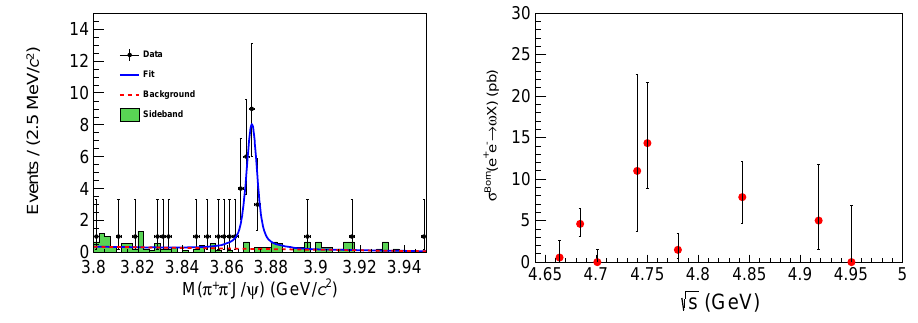
Figure 2. The X (3872) signal recoiling against ω in e + e − annihilation (left panel) and cross sections of e + e − → ω X (3872) (right panel) from BESIII experiment [18].